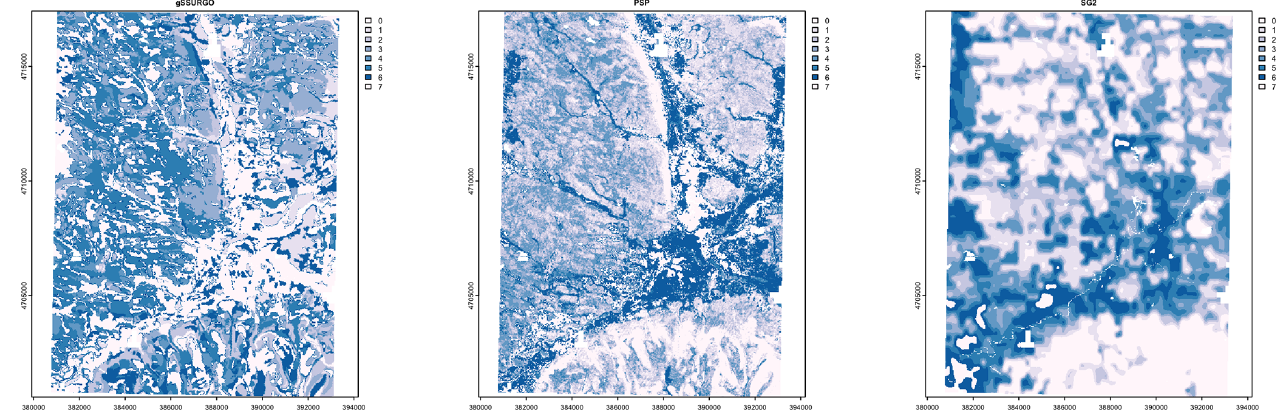
Figure 23. The pH classes at 0–5cm. The coordinates are UTM18N (in metres).